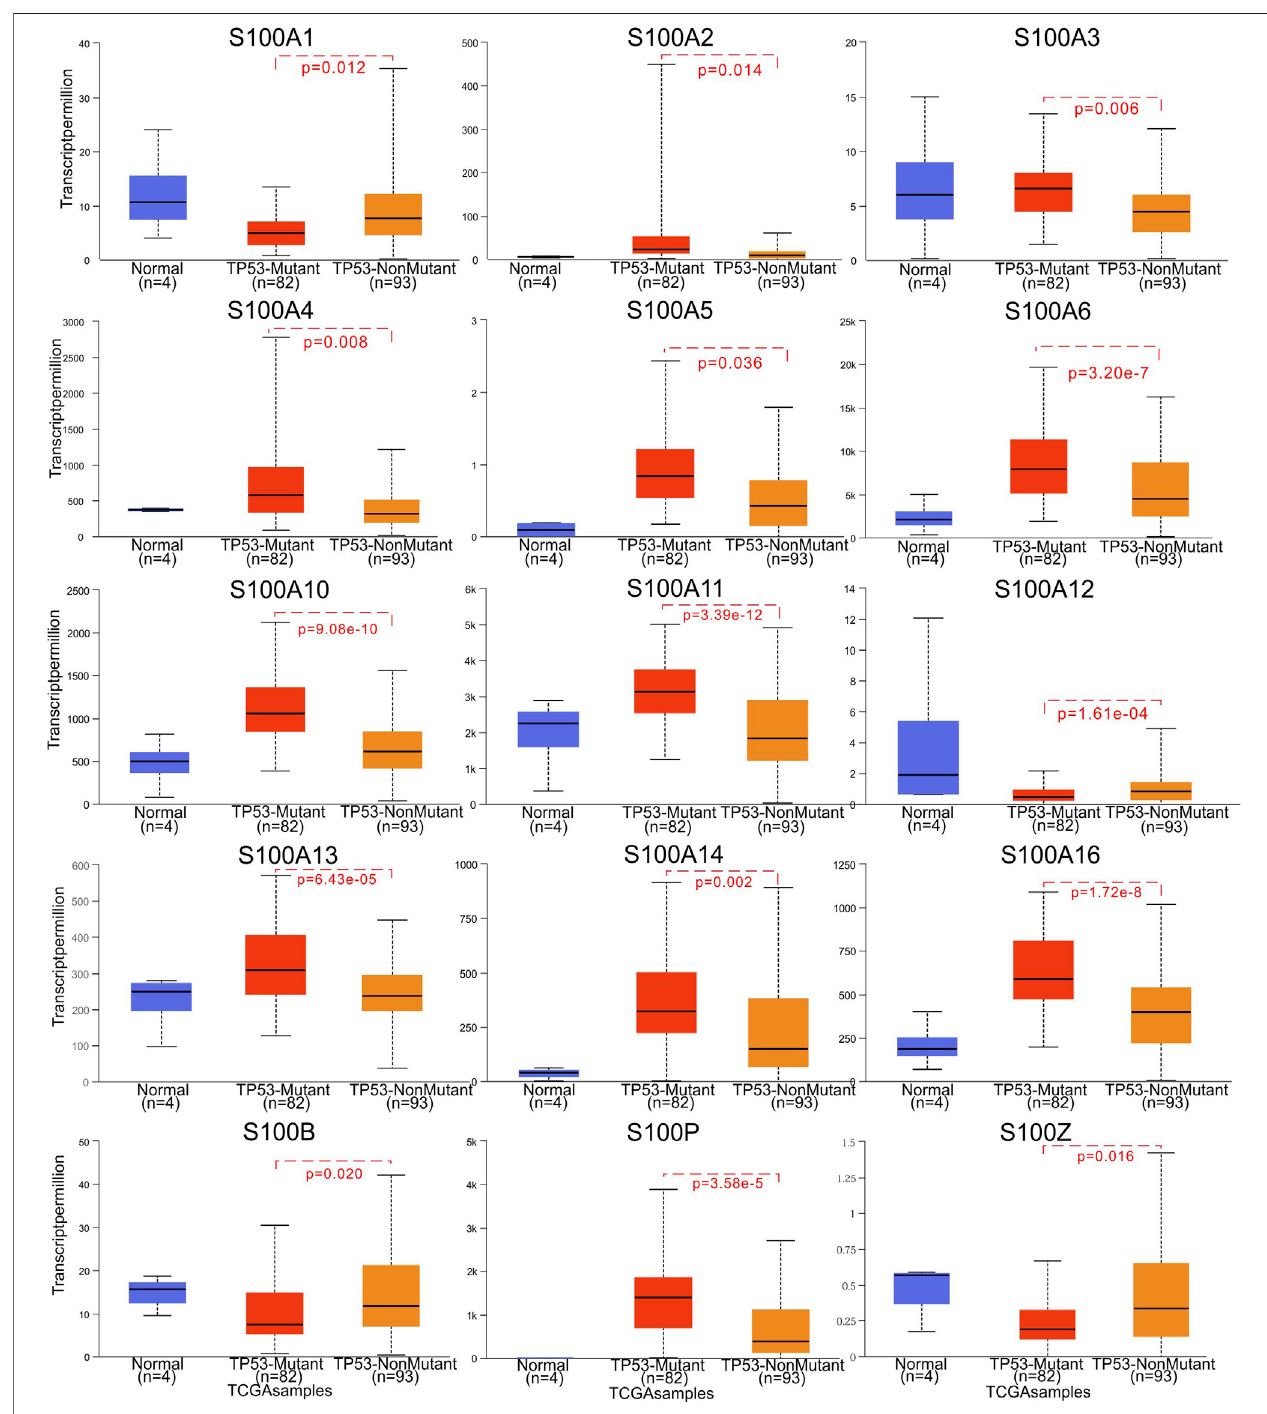
FIGURE5| CorrelationbetweenS100smRNAexpressionandTP53mutationinPAAD(UALCAN).Thesigni fi canceofdifferencebetweenTP53-mutantandTP53- nonmutant estimated by Student ’ s t-test with p value. The sample number N and the Student ’ s t-test p value are marked on the fi gure, respectively.